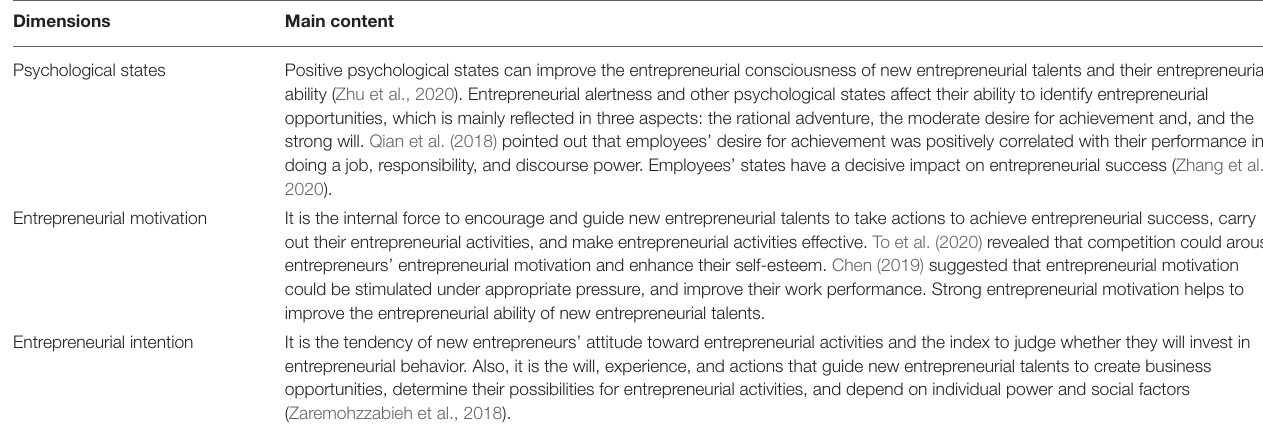
TABLE 3 | The individual driving mechanism of new entrepreneurial